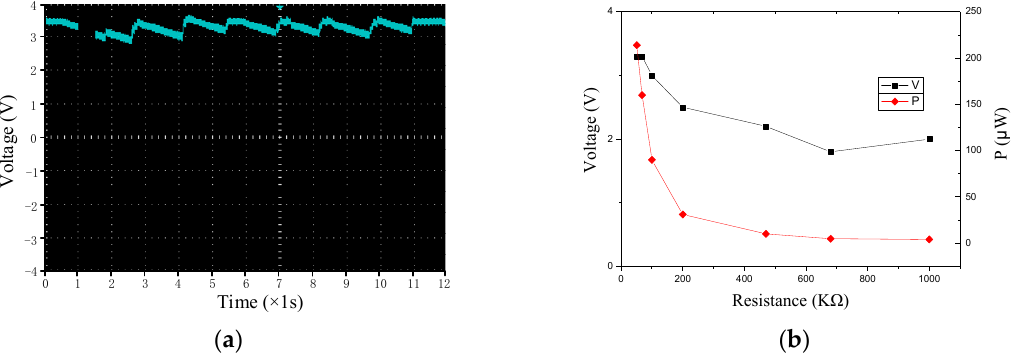
Figure 15. Output after energy harvesting circuit. ( a ) output voltage; and ( b ) voltage and power.